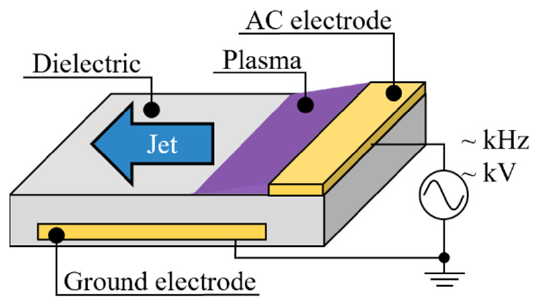
Figure 1. Schematic of a dielectric barrier discharge plasma actuator.